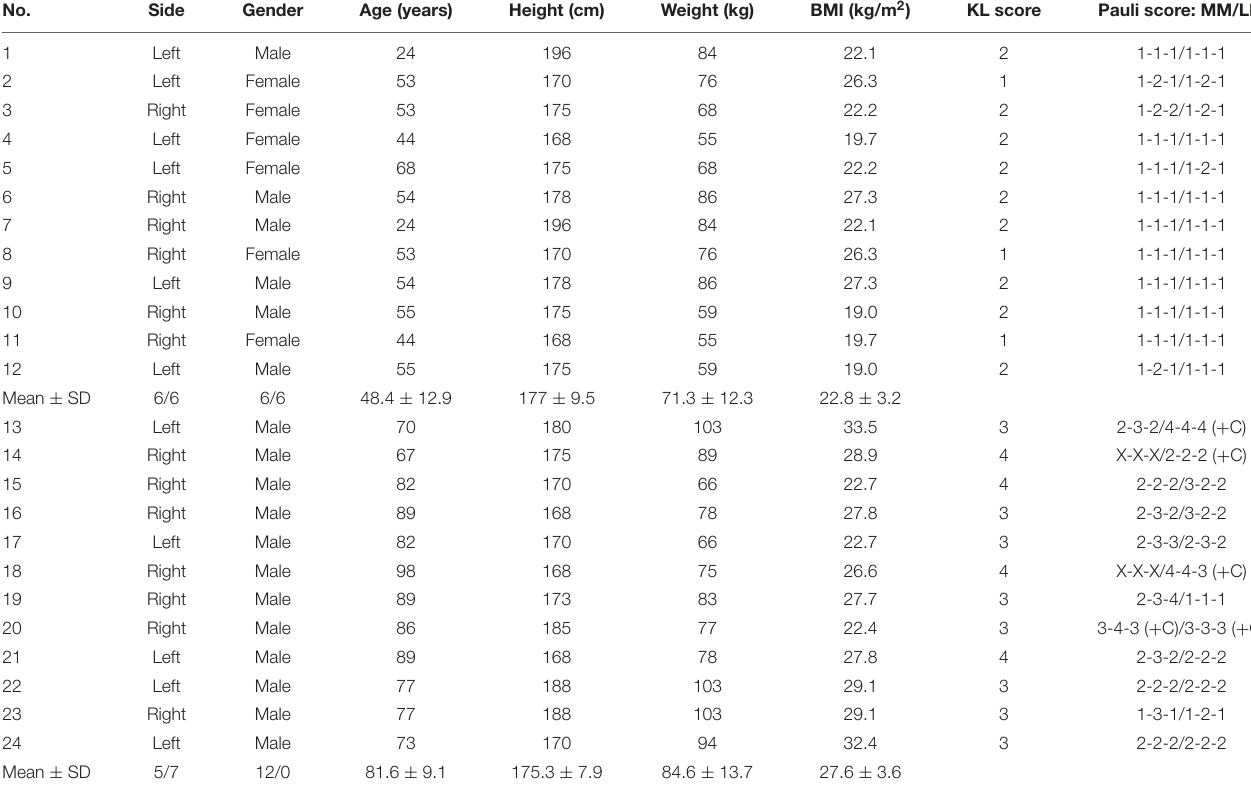
The mean ± SD values of the respective group are summarized in the respective lower gray-shaded row. Kellgren–Lawrence (KL) scores range from 1 (normal knee joints to doubtful degeneration signs) to 4 (severe degeneration with greatly reduced joint space, subchondral sclerosis, etc.). Macroscopic Pauli scoring for the medial (MM) and lateral (LM) menisci, where the degrees of degeneration between 1 for inconspicuous changes/normal tissue and 4 for the most strongly altered tissue were defined. Furthermore, the meniscus regions (anterior horn–pars intermedia–posterior horn) were considered in the macroscopic Pauli meniscus score, while the three subsequent scores represent the respective meniscus region. In the case where the meniscus showed macroscopically visible calcification, ( + C) was added. The grading “X” represents the maximum degeneration state where the meniscus was only piecewise available.